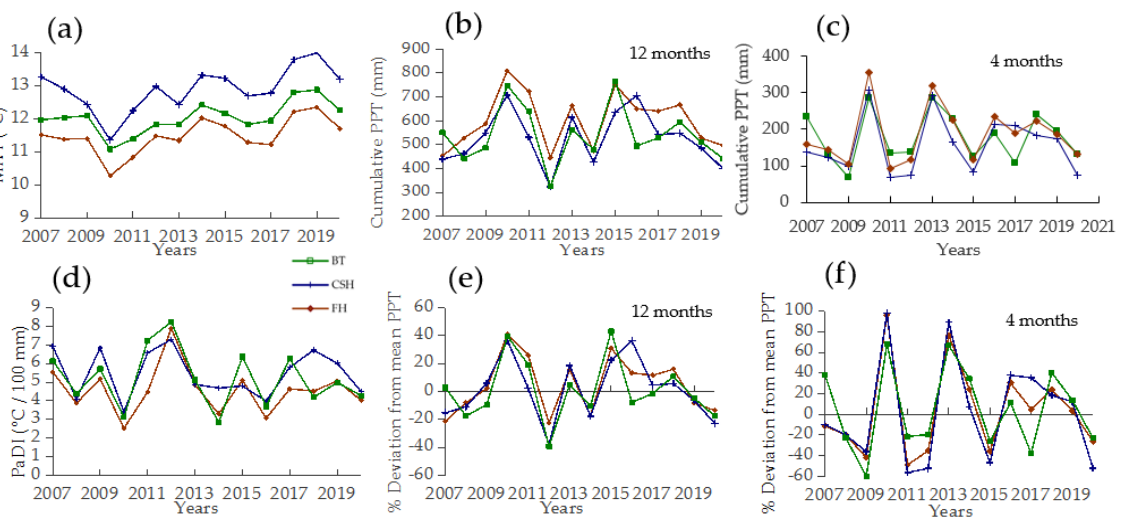
Figure 2. Temporal patterns of weather characteristics at the three study sites. BT = Battonya site (loess meadow steppe), CSH = Csévharaszt site (sand steppe 1), FH = Fülöpháza site (sand steppe 2). ( a ) MAT = Mean annual temperature (°C); ( b , c ) PPT cumulative precipitation (mm) over 12 months and 4 months before the vegetation sampling date; ( d ) PaDI 0 = Pálfai aridity index (°C/100 mm); ( e , f) = Relative variability of cumulative precipitation expressed as a percentage deviation from the temporal mean values. Mean values were calculated separately for each site.